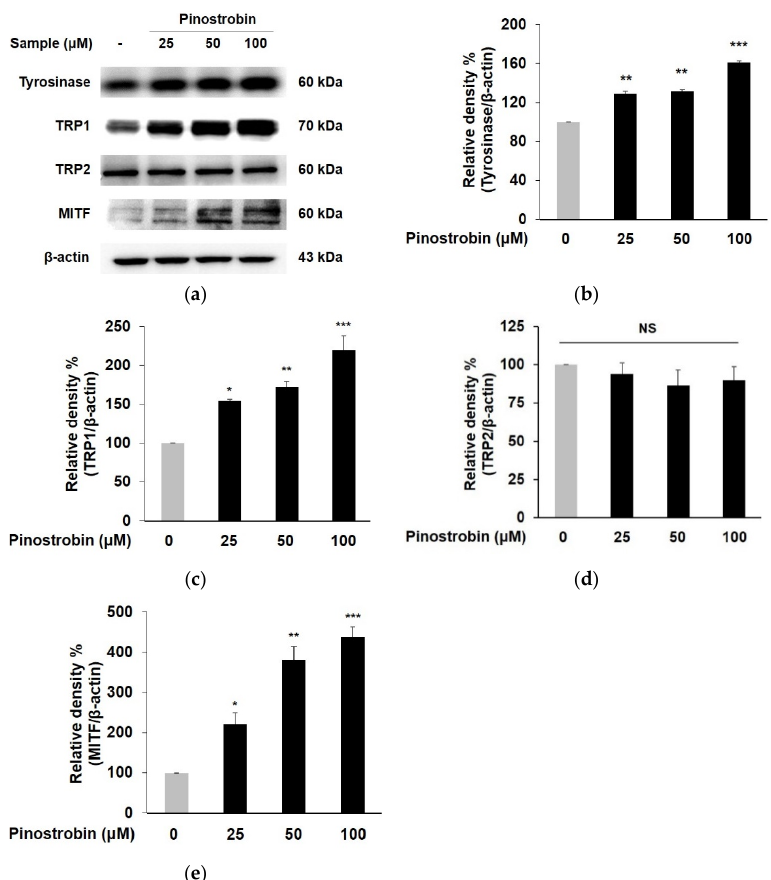
Figure 2. Effect of pinostrobin on the protein levels of tyrosinase, TRP 1, TRP 2, and MITF in B16F10 cells. Cells were treated with pinostrobin at various concentrations for 24 h. ( a ) Tyrosinase, TRP 1, TRP 2, and MITF, were analyzed by Western blotting. ( b – e ) Blots were quantified using ImageJ software. β -actin is used as a loading control for quantitative Western blotting. The untreated cells were regarded as 100%. Values are expressed represent as the mean±SD of three independent experiments. *** p < 0.001, ** p < 0.01 and * p < 0.05 compared with control group. NS; not significant.